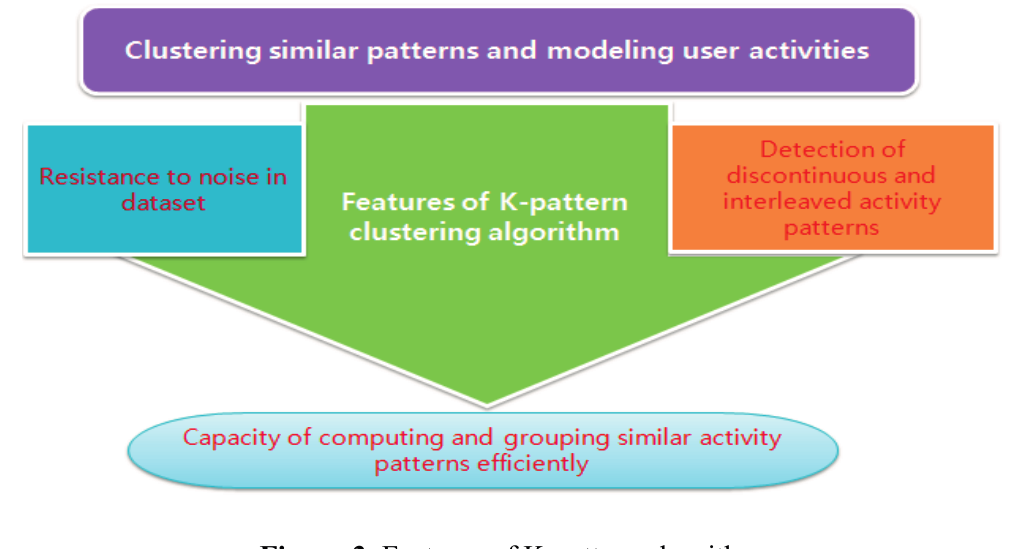
Figure 3. Features of K-pattern